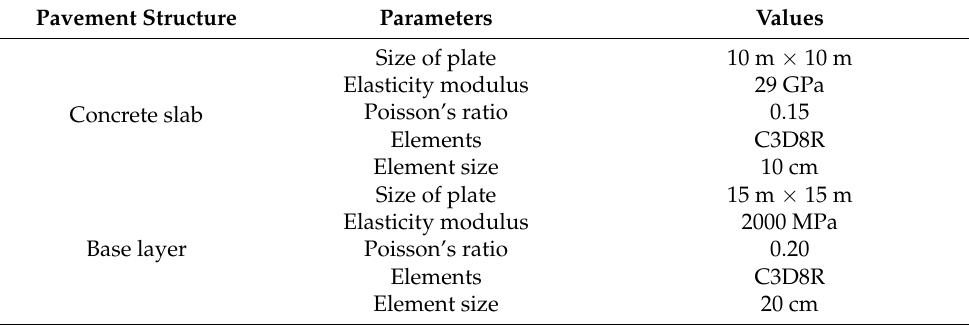
Table 5. Loading parameters of the landing gears for selected typical aircraft.